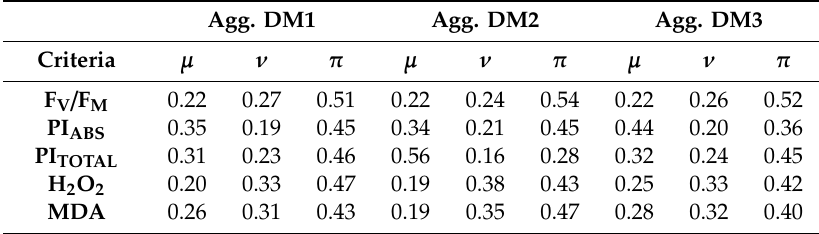
Table 10. Aggregated IF decision matrices for criteria of drought subcategories.